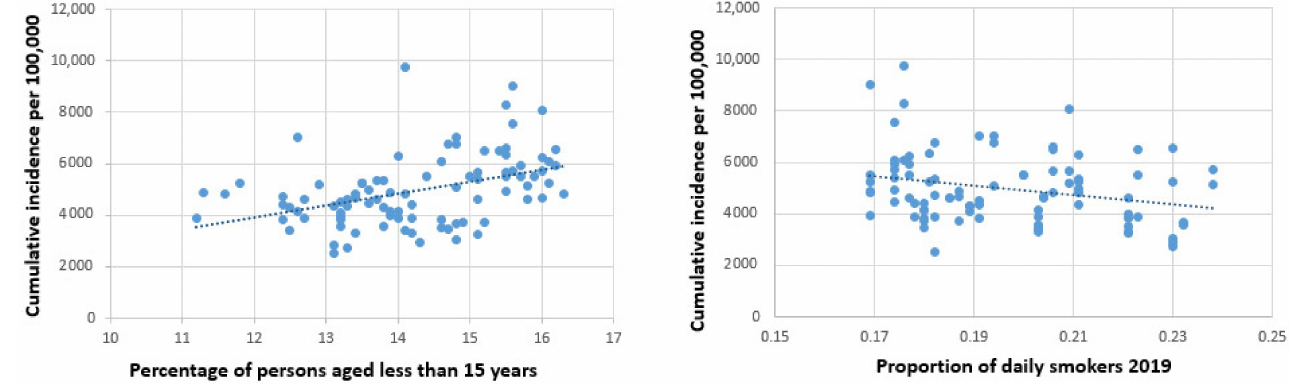
Figure 4. Scatterplots for young age ( left ) and daily smoking ( right ) with cumulative incidence.